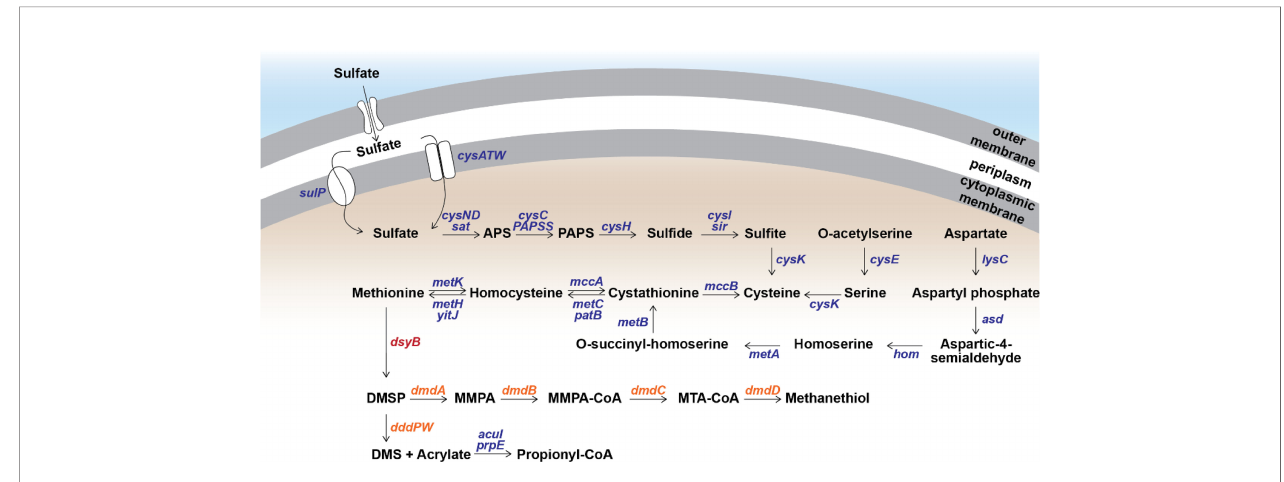
FIGURE 3 | Metabolism of methylated sulfur compounds in Shimia aestuarii AMM-P-2. Orthologous genes for each step are presented in blue. The DMSP production gene dsyB is presented in red, while the catabolism genes are in orange. E-values and additional information can be found in Table S3